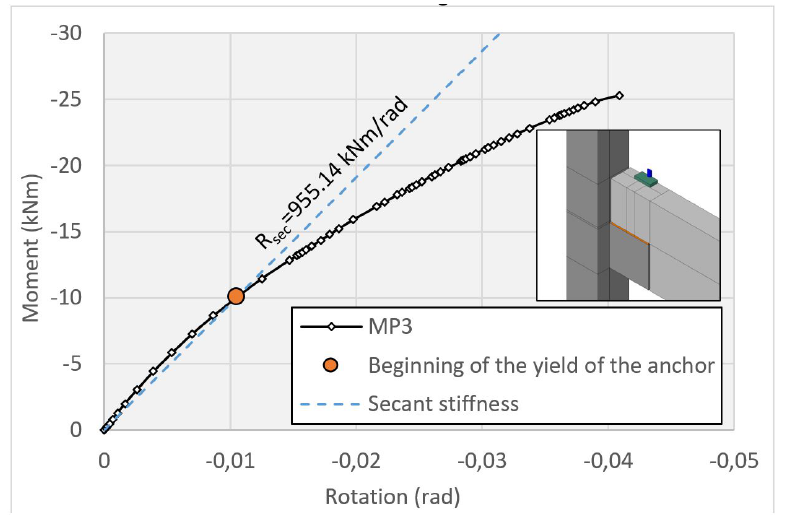
Figure 14. MP3 moment-rotation